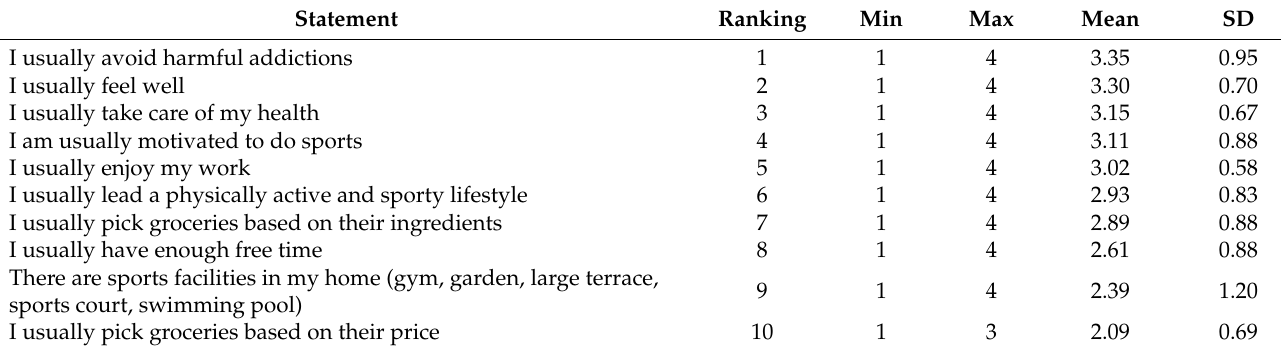
Table 5. Health behavior in everyday life (N =